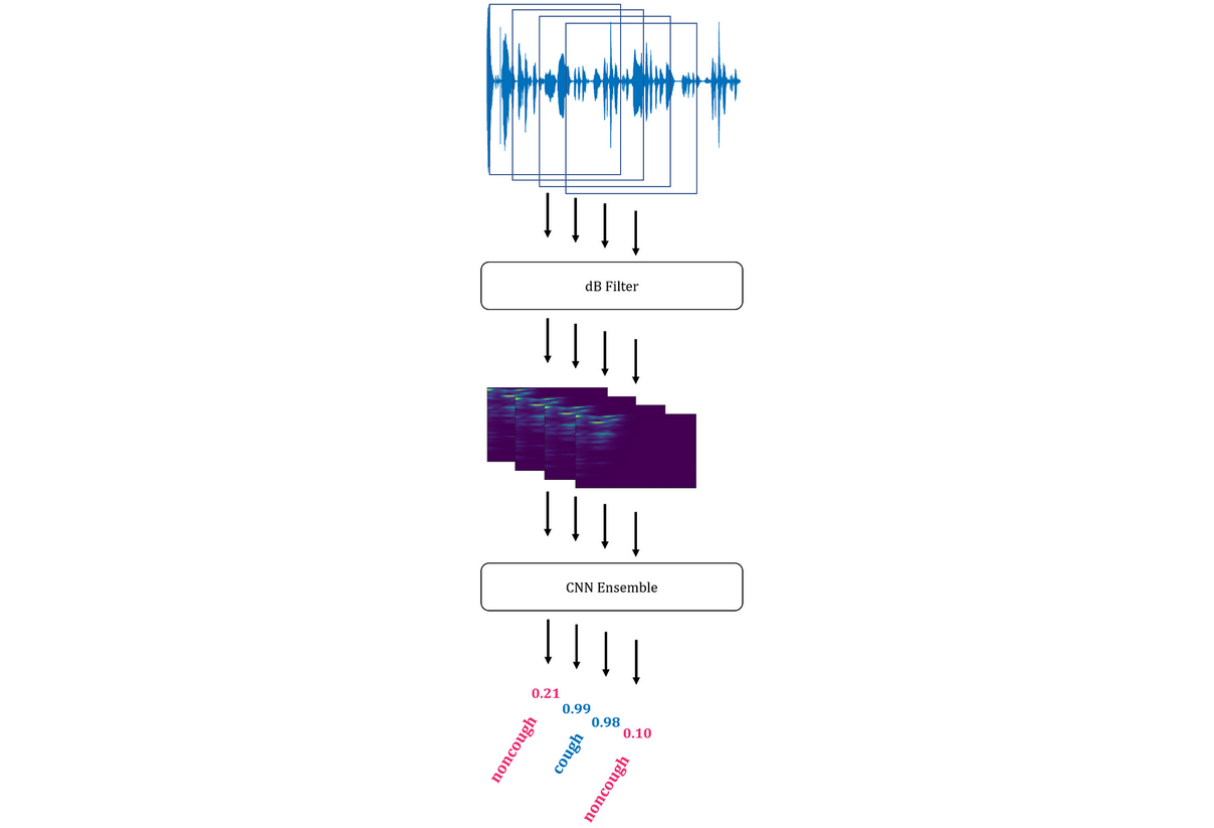
Figure 2. The steps for the segmentation of coughs from continuous audio recordings (from top to bottom): First, the continuous extraction of overlapping windows from continuous audio recordings; second, the discarding of silent windows by applying a dB filter; third, the computation of Mel spectrograms; fourth, the computation of the prediction probability of cough by the convolutional neural network ensemble; last, the recognition of cough by applying the postprocessing rules. CNN: convolutional neural